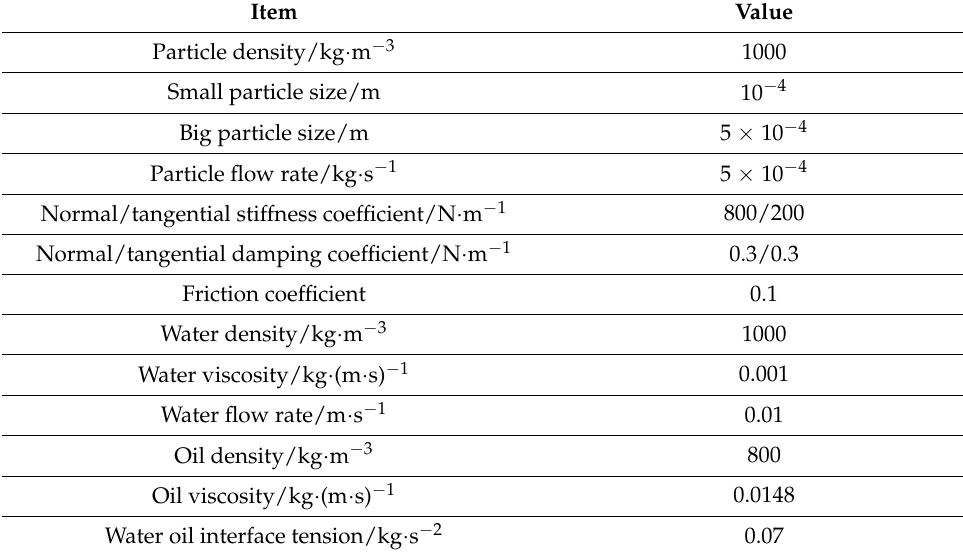
Table 2. Physical parameters used in particle